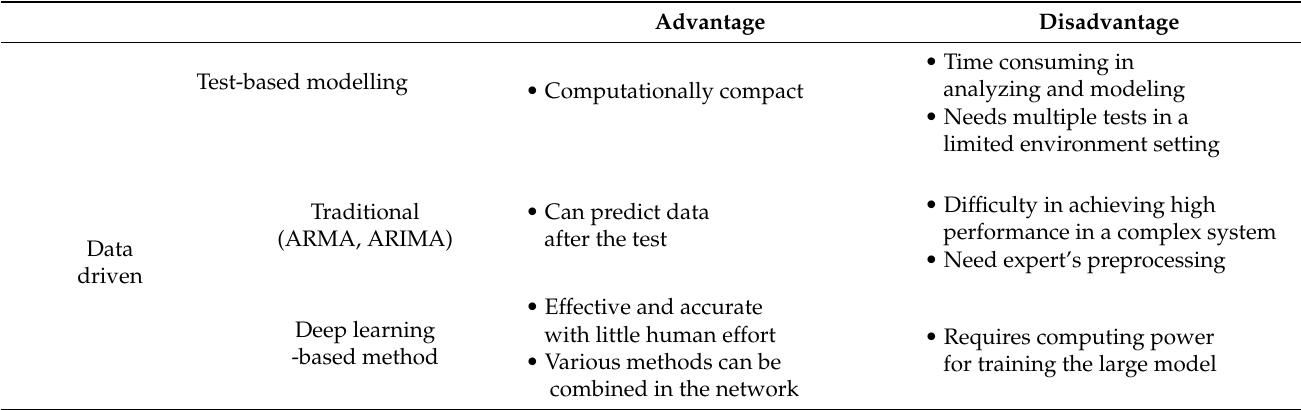
Table 1. Categories of sensor prediction methods. Advantage